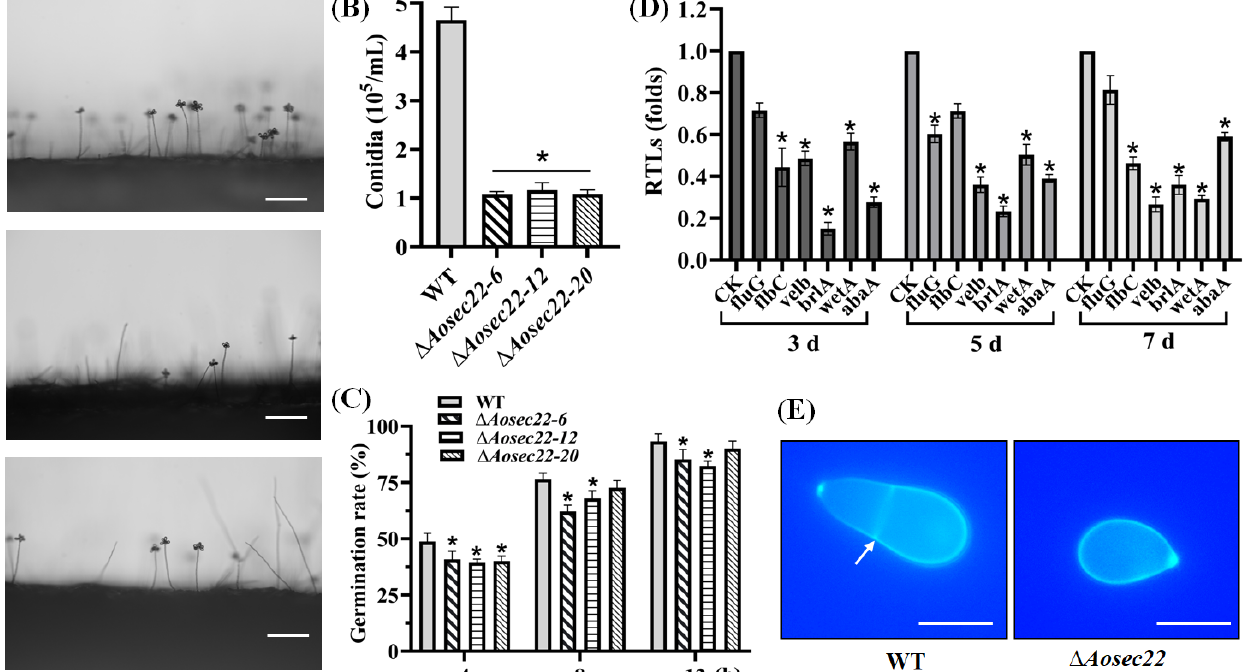
Figure 2. Role of AoSec22 in conidiation and conidial morphology. ( A ) Microscopic images (scale: 50 μm) for conidiat ion of the WT and mutant strains on PDA. ( B ) Spore yields assessed from 15- days-old cultures. ( C ) Spore germination rate during normal incubation. ( D ) Relative transcription levels (RTLs) of sporulation-related genes in the WT and mutant strains. An asterisk ( B – D ) indicates a significant difference between the mutant and WT strains ( p < 0.05). CK was used as the standard (RTL = 1) for statistical analysis of the RTL of each gene under a given condition. ( E ) Microscopic images (scale: 10 μm) of conidia stain ed with calcofluor white (CFW). The white arrow indicates the septum.